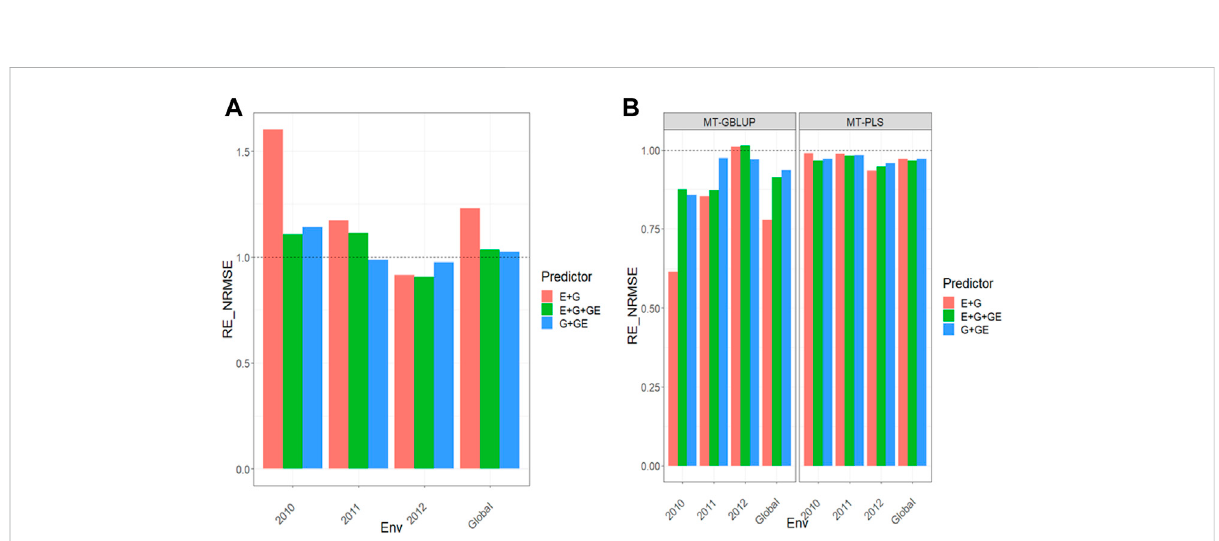
FIGURE 4 (A) Relative ef fi ciency in terms of normalized root mean square error (RE_NRMSE) computed by dividing the NRMSE under the multi-trait best linear unbiased predictor model (MT-GBLUP) by the NRMSE of the multi-trait partial least square regression method (MT-PLS). Prediction performance is reported across traits for each environment and across environments (Global) in dataset 4 (Indica), also with three predictors (E + G, E + G + GE and G + GE). When the RE_NRMSE > 1 the MT-PLS outperform in terms of prediction performance (lower NRMSE) the MT-GBLUP method. (B) Relative ef fi ciency in terms of normalized root mean square error (RE_NRMSE) computed by dividing the NRMSE of either the UT best linear unbiased predictor model (UT-GBLUP) or UT partial least square regression method (UT-PLS), by the NRMSE of either MT-GBLUP or MT-PLS method.Predictionperformanceisreportedacrosstraitsforeachenvironmentandacrossenvironments(Global)indataset4(Indica),alsowiththree predictors (E + G, E + G + GE and G + GE). When the RE_NRMSE > 1 the multi-trait method outperform in terms of prediction performance (lower NRMSE) the UT